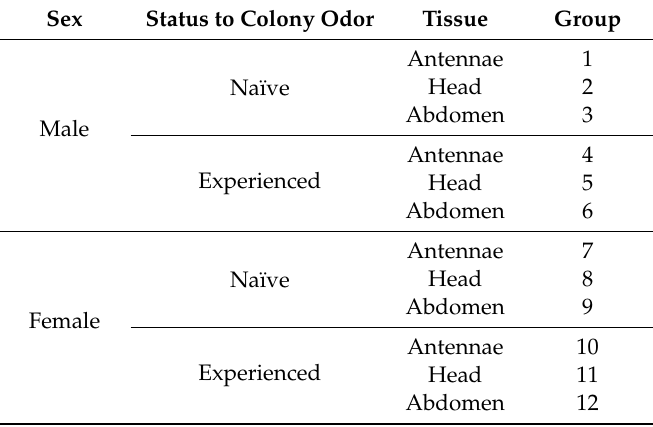
Table 1. Overview of the 12 treatments used for the odorant receptor gene expression profiles. Total RNA was extracted from each SHB body parts (antennae, head, and abdomen) for 15 beetles for each of four groups (male–naïve, male–experienced, female–naïve, and female–experienced). Sex Status to Colony Odor Tissue Group Antennae 1 Head 2 Naïve Abdomen 3 Male Experienced